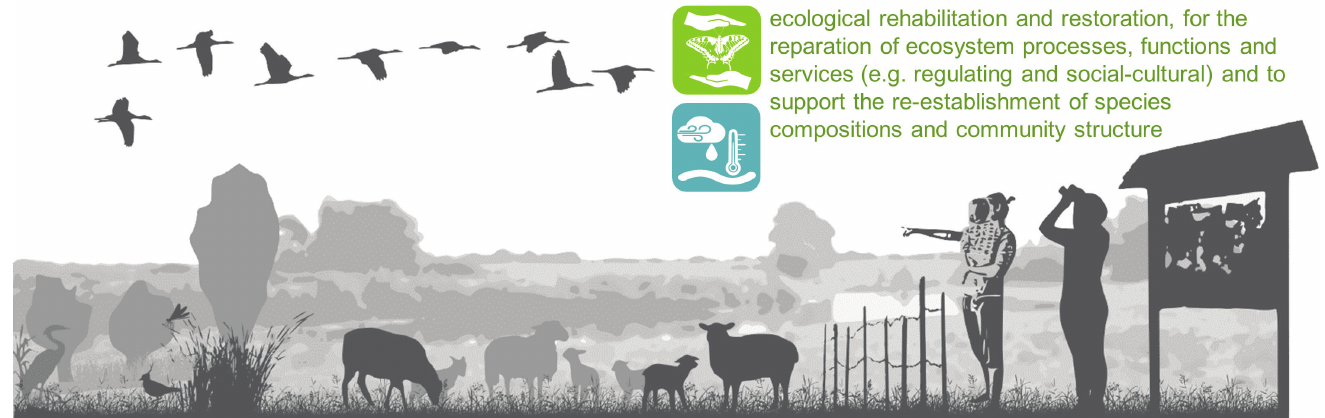
Figure 8. Illustration of adapted farmland with potential key functions and benefits addressing urban